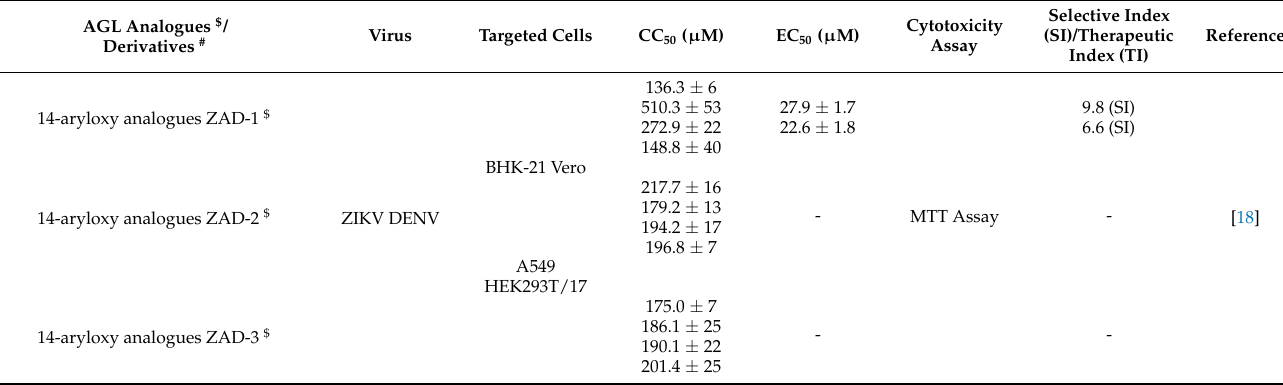
Table 1. AGL analogs and derivatives with their activity level (CC 50, EC 50, SI/TI) on selective cell lines, cytotoxicity assay against target